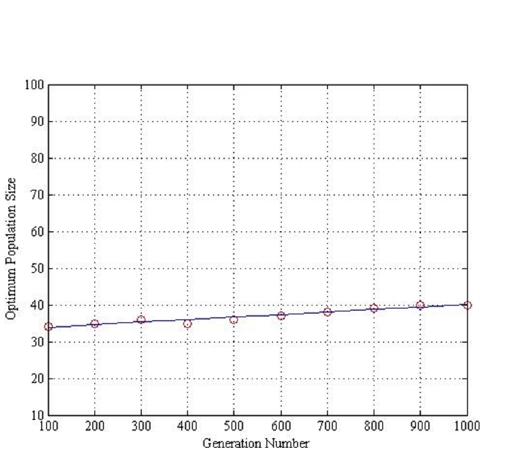
Fig 7. Average path and computational cost between various population sizes and generation numbers at the optimum crossover and differential weight “ Table D in S1 Dataset. ”